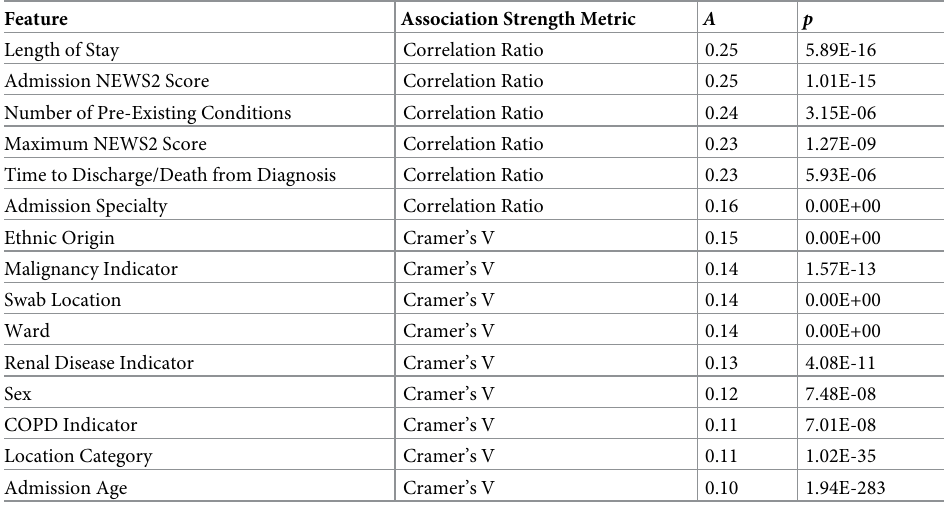
Table 3. Association between patient variables and SARS-CoV-2 mutations.